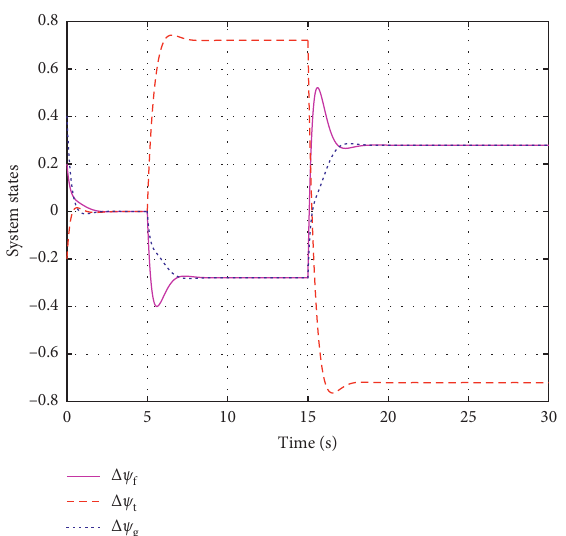
Figure 6: Dynamics of the attack